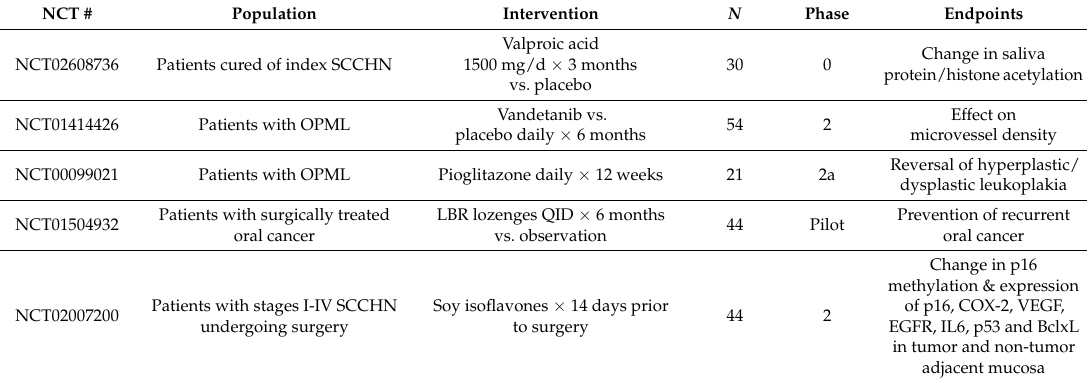
Table 3. Trials currently accruing patients for SCCHN